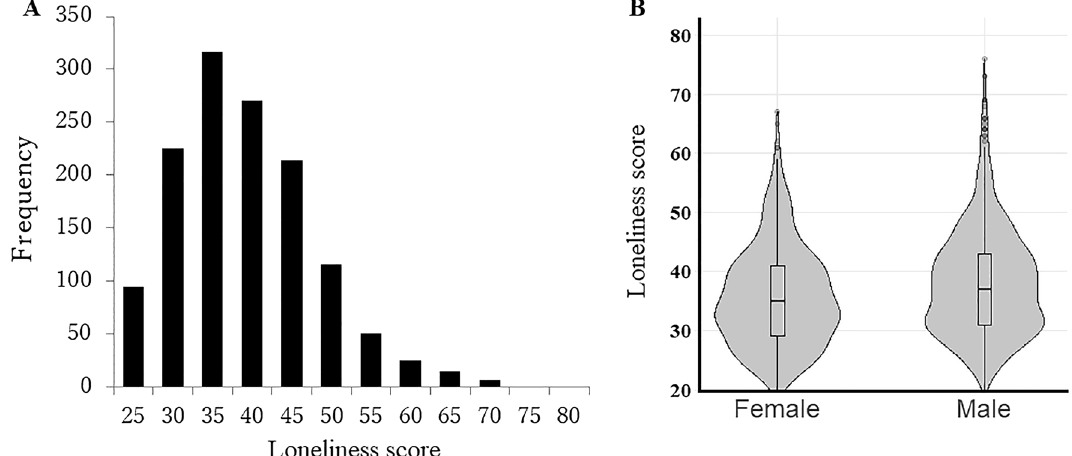
Figure 1. The distribution of loneliness among participants. ( A ) Overall distribution. ( B ) Female-male distribution.